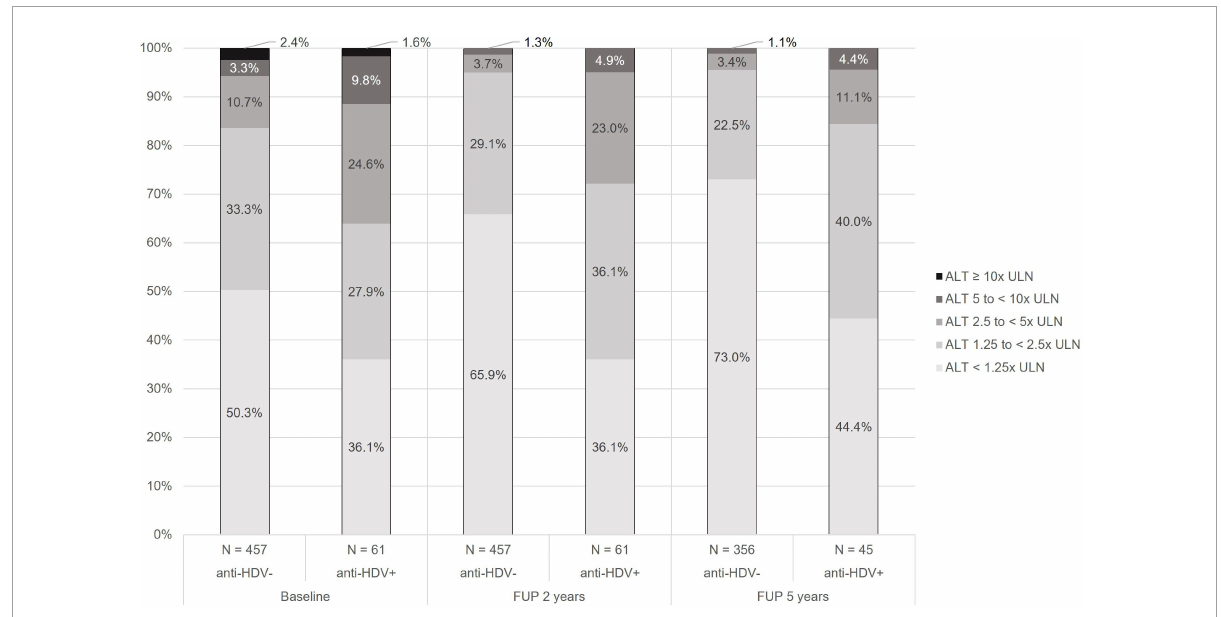
FIGURE1 Grade of alanine aminotransferase (ALT) elevation at start, after 2 years and after 5 years of tenofovir treatment by anti-hepatitis delta antibody (anti-HDV) status. Grading according to the National Institutes of Health’s Division of acquired immunodeficiency syndrome (AIDS) (14). ALT, alanine aminotransferase; anti-HDV, anti-hepatitis delta antibodies; FUP, follow-up; ULN, upper limit of normal.